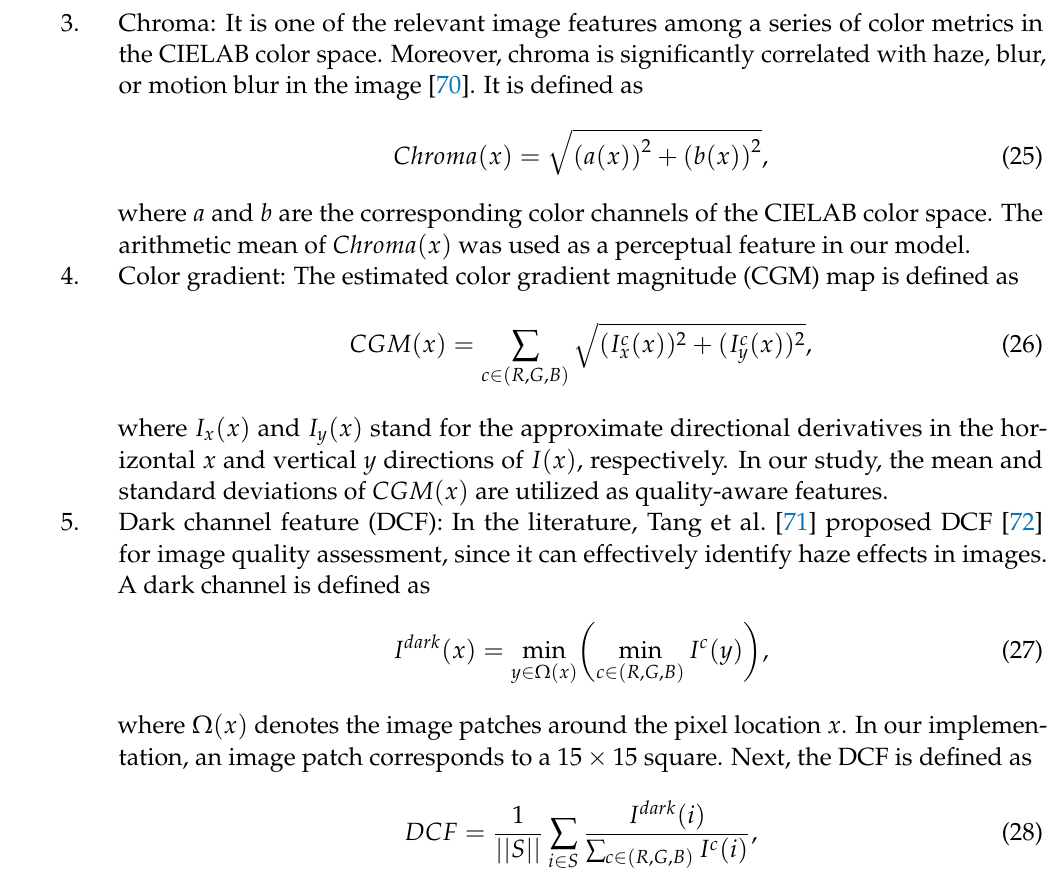
where || S || is the size of image I . 6. Michelson contrast: Contrast is one of the most fundamental characteristics of an image, since it influences the ability to distinguish objects from each other in an image [73]. Thus, contrast information is built into our NR-IQA model. The Michelson contrast measures the difference between the maximum and minimum values of an image [74], defined as